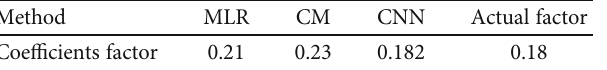
Table 8: The calculated corresponding connectivity coe ffi cients for comparative